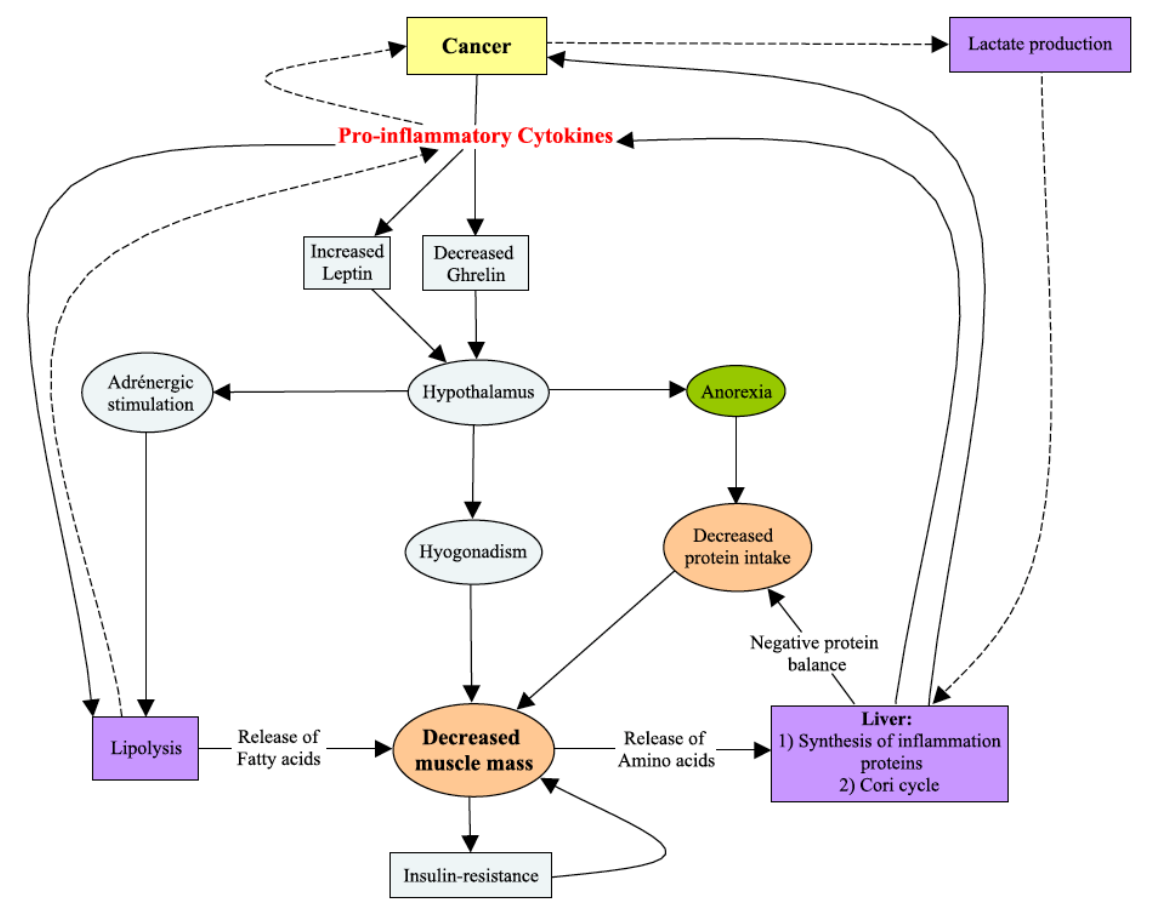
Figure A3. Common pathways of cancer-cachexia.